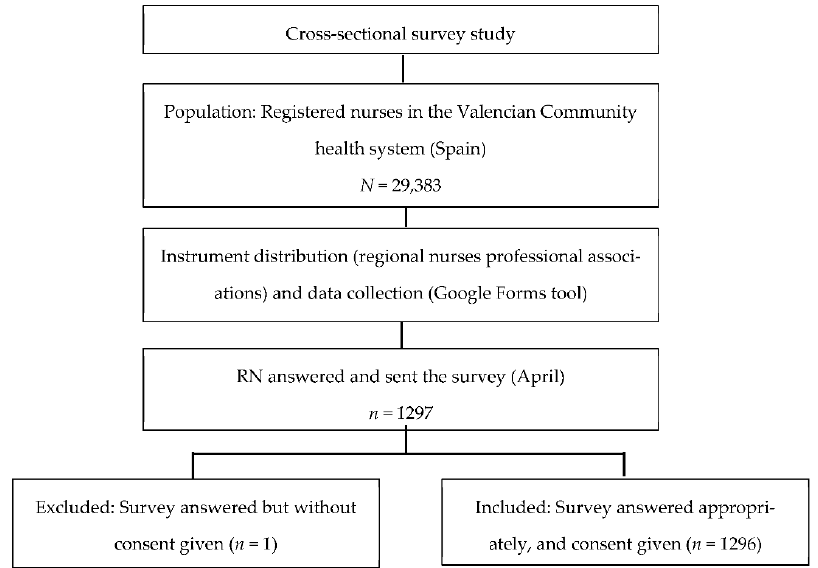
Figure 1. Flow diagram of the study.